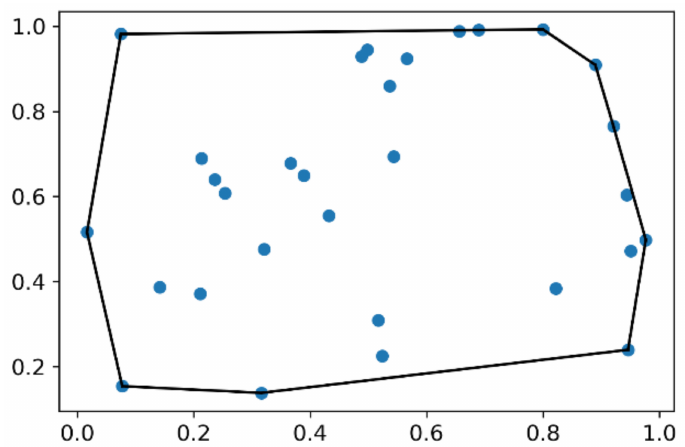
Figure 2. Example of convex hull which is the set of points joined by the black